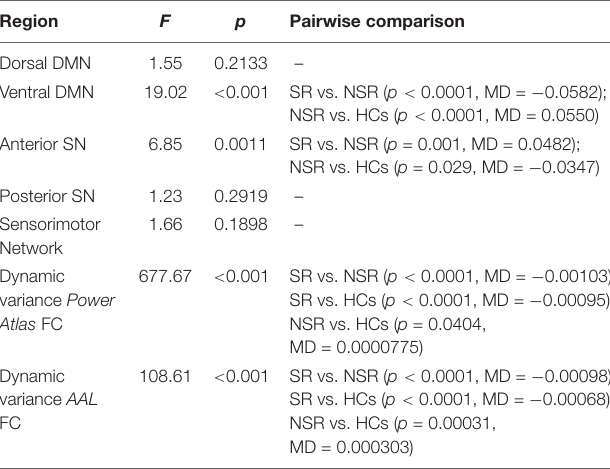
TABLE 3 | The 10 most important features for Logistic Regression and LASSO